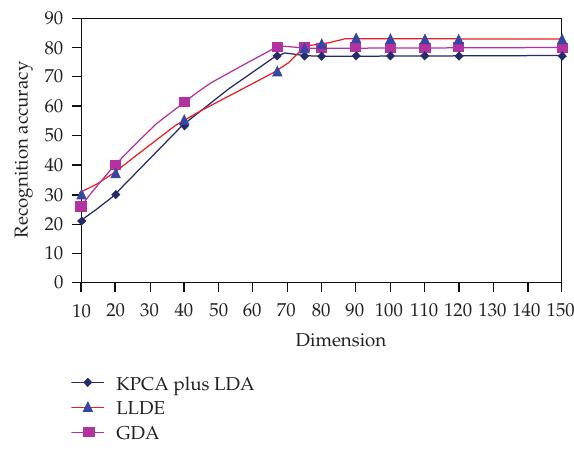
Figure 8: The recognition rates of the KPCA plus LDA, GDA, and